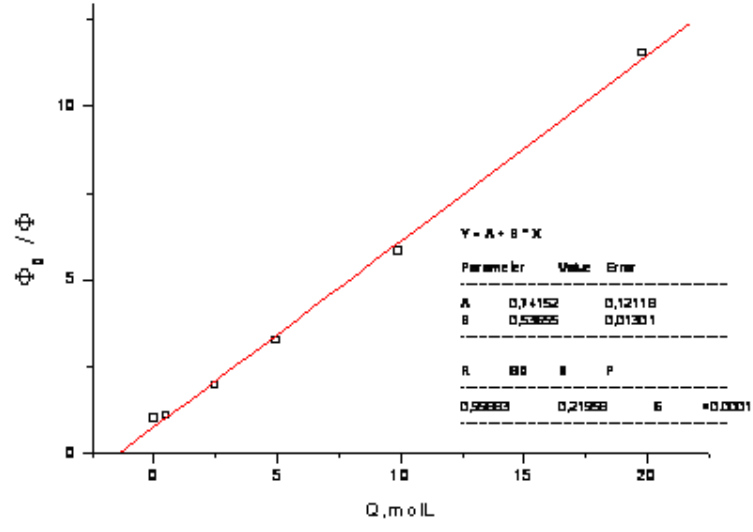
Figure 13. Stern-Volmer-like plot of fluorescence quenching of 1 in chloroform by polar methanol (K = 0.54 mol − 1 dm 3 ). SV